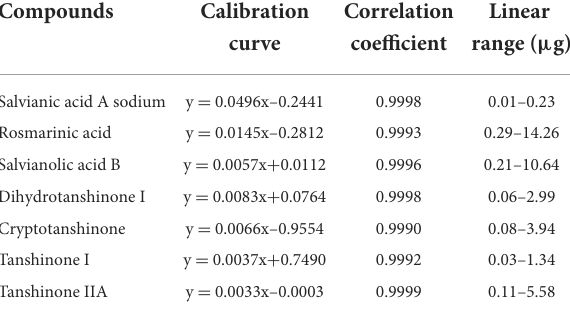
TABLE 1 The main parameters of the developed HPLC-DAD method. Compounds